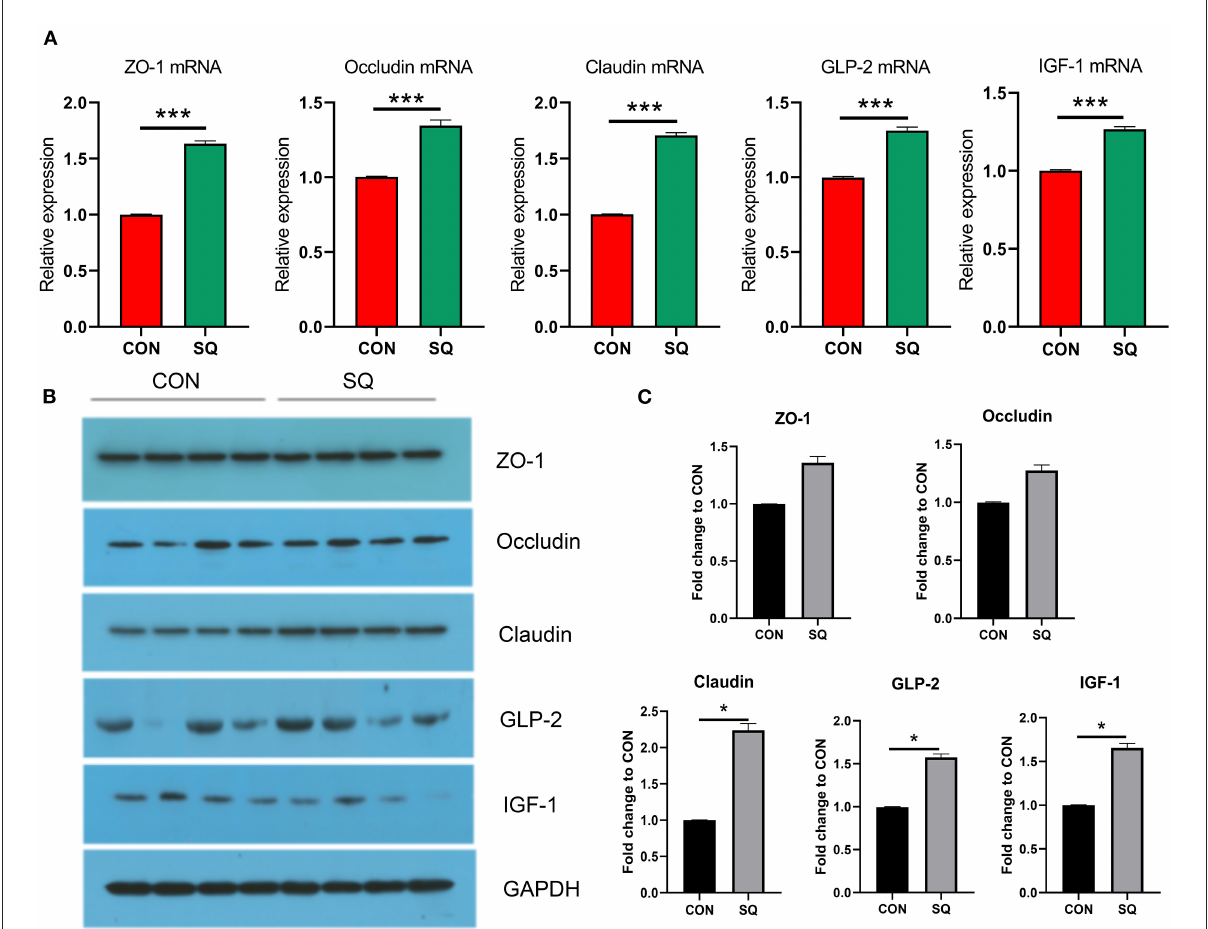
FIGURE4 SQ is beneficial for improving the intestinal barrier of weaned piglets. (A) mRNA expression in the intestinal barrier. Y-axis = Relative expression, X-axis = the treatment groups. *** P < 0.001. (B) Tight junction protein levels of jejunum detected by Western blotting (N > 3). (C) Quantitative data for western blotting analysis. Y-axis = fold change to CON, X-axis = the treatment groups (mg/kg body weight). * P <